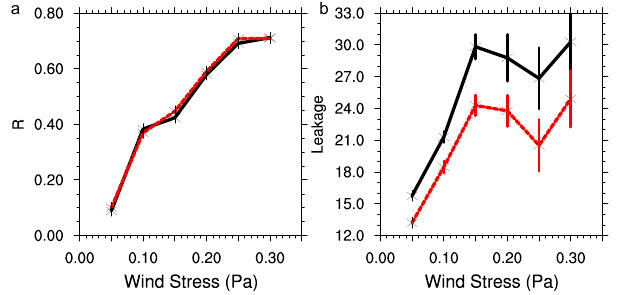
Fig. 9. Retroflection index (a) and Agulhas leakage (b) as a func- tion of wind stress for HIM CTRL (black) and HIM NoITF (red). Each cross represent a statistical steady state and vertical bars rep- resent the 95% confidence interval for the computation of the mean Agulhas leakage.